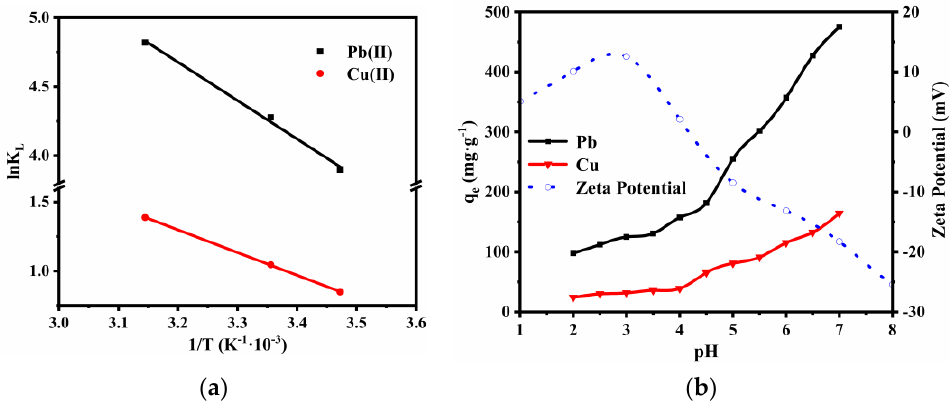
Figure 16. The linear regression of the curve of ln K L versus 1/ T ( a ) and the adsorption capacity of SS@CNTs for Pb(II) and Cu(II) with pH from 2 to 7 and the values of the zeta potential at different pH values ( b ). Table 10. The thermodynamics parameters of the adsorption process at different temperatures.